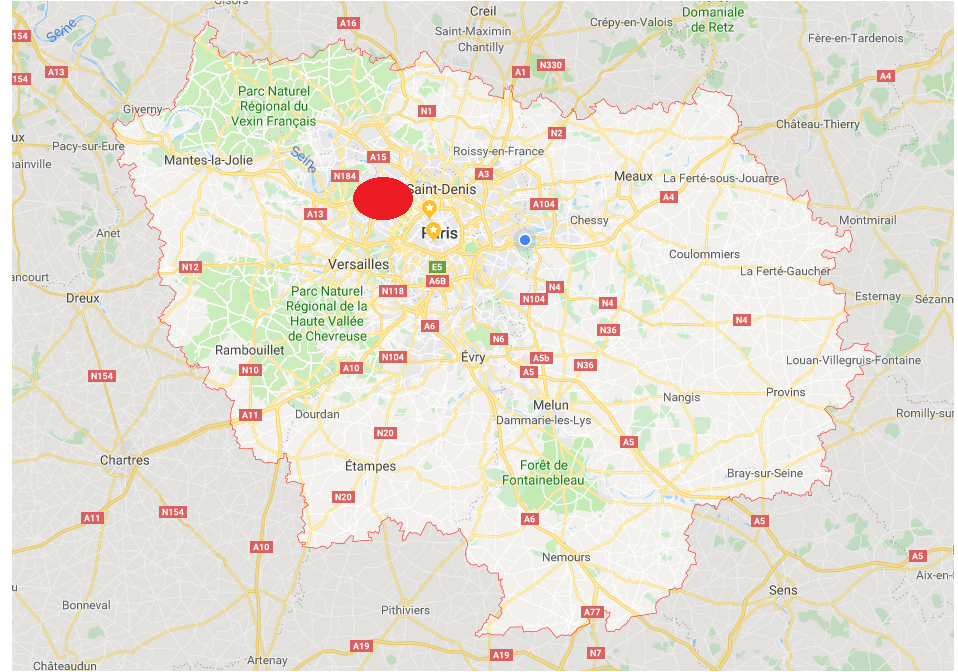
Figure 5. Use case study area (La Défense is located inside the red